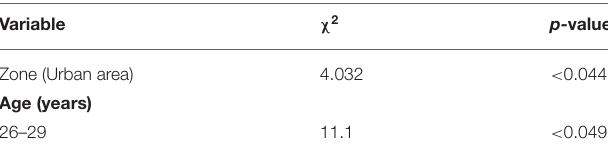
TABLE 3 | Likelihood ratio test χ 2 values of all significant variables in the final generalized linear model on the probability of abandoning treatment. Variable χ 2 p-